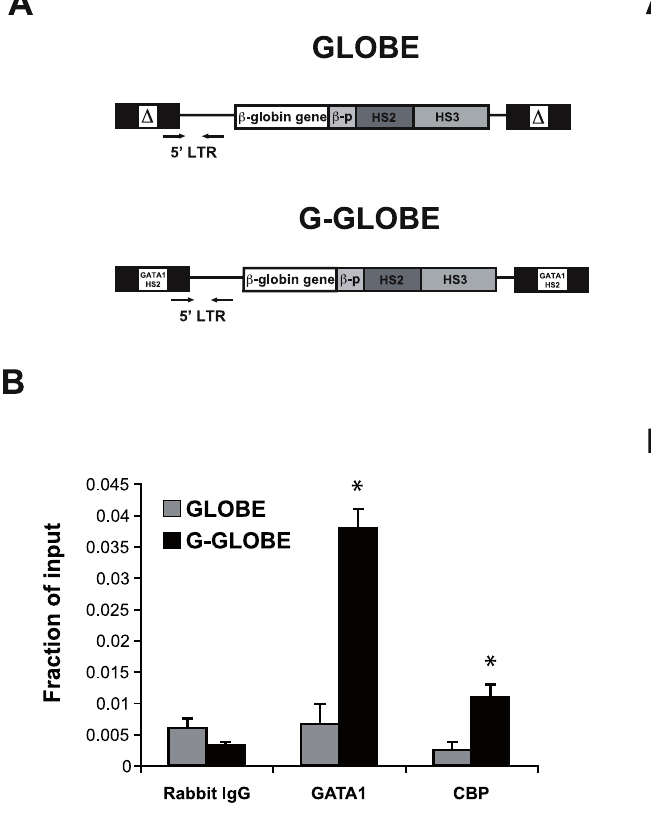
Figure 6. GATA1 and CBP bind to GATA1 -HS2-containing 5 9 LTRs. HEL cells were transduced with GLOBE and G-GLOBE and ChIP assay was performed using antibodies against GATA1 and CBP. (A) Schematic map of GLOBE and G-GLOBE vectors. Arrows indicate the primer pairs used to amplify by PCR the viral 5 9 LTR. (B) Chromatin was immunoprecipitated with antibodies against GATA1 and CBP and isotype-matched control antibodies (Rabbit IgG). GATA1 and CBP binding to the 5 9 LTR of GLOBE and G-GLOBE vectors was measured by real-time PCR. GATA1 and CBP are detected only at the GATA1 -HS2-containing 5 9 LTRs (n=2). *P , 0.05 by Student t test. Error bars represent SEM.